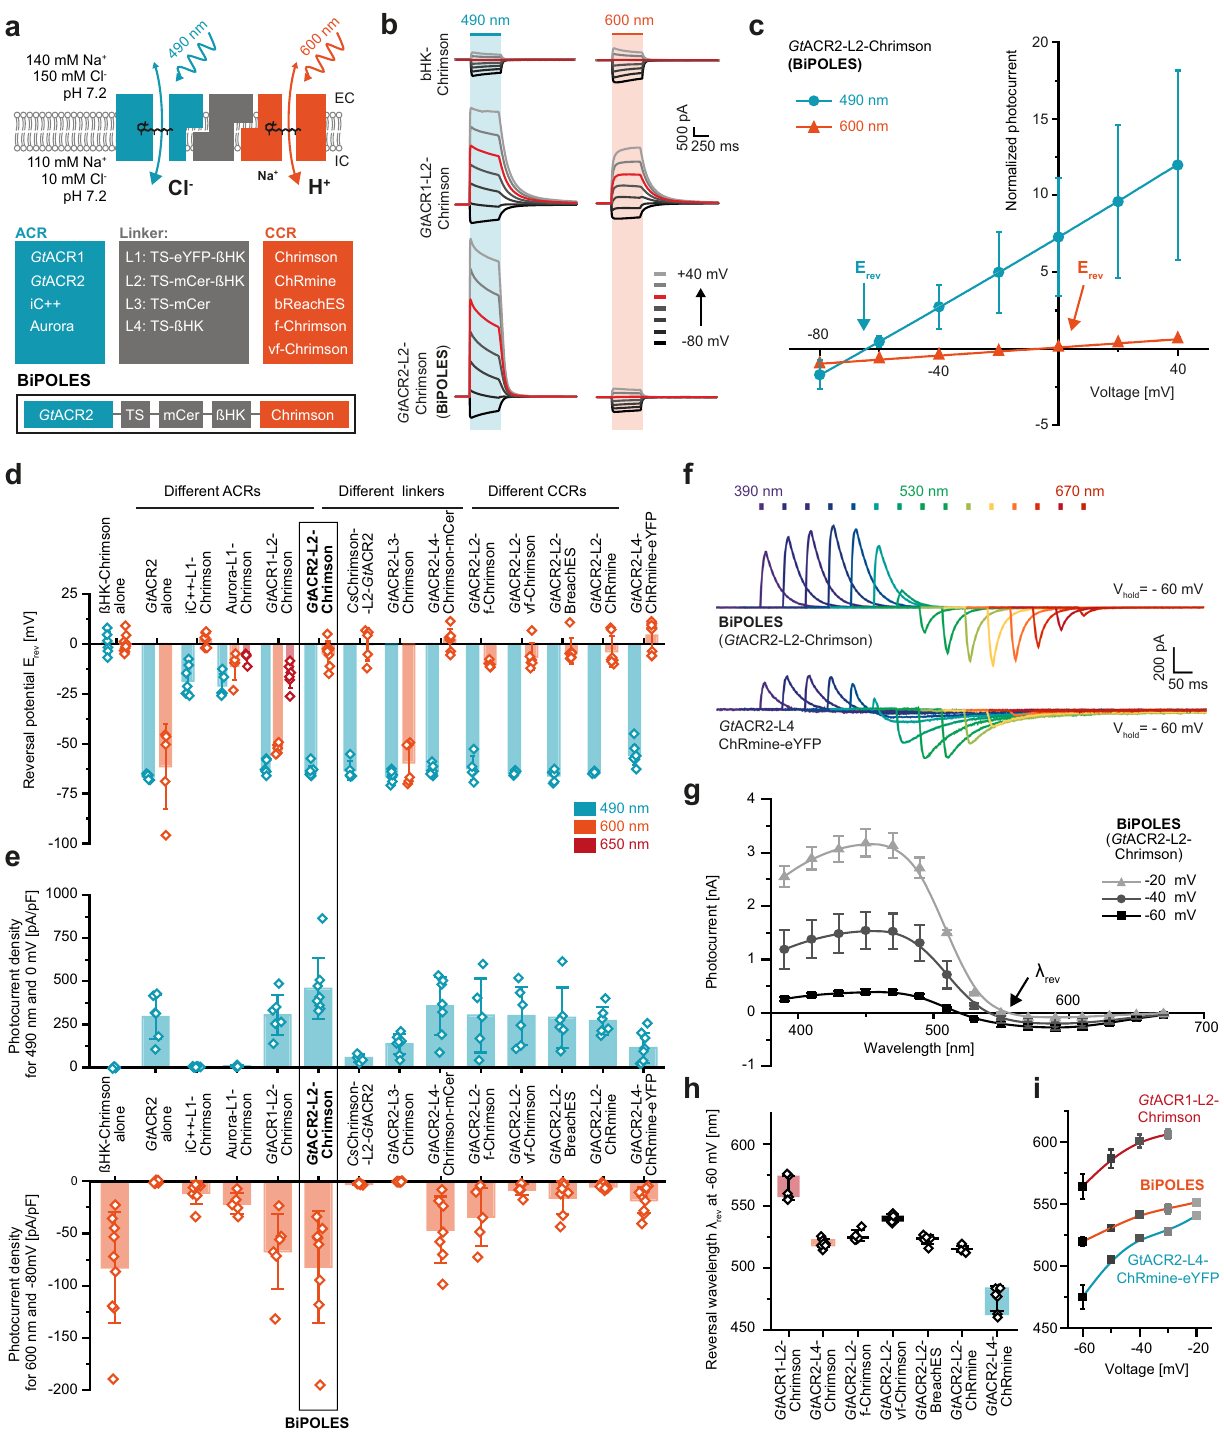
harboring a Gt ACR reached similar membrane expression ef fi cacy as the individually expressed channels (Fig. 1e). At membrane potentials between the Nernst potentials for chloride and protons, blue and red light induced outward and inward currents, respectively, in all Gt ACR-fusion constructs. (Fig. 1e – g, Supplementary Fig. 1). The speci fi c wavelength of photocurrent inversion ( λ rev ) was dependent on the absorption spectra and relative conductance of the employed channels, as